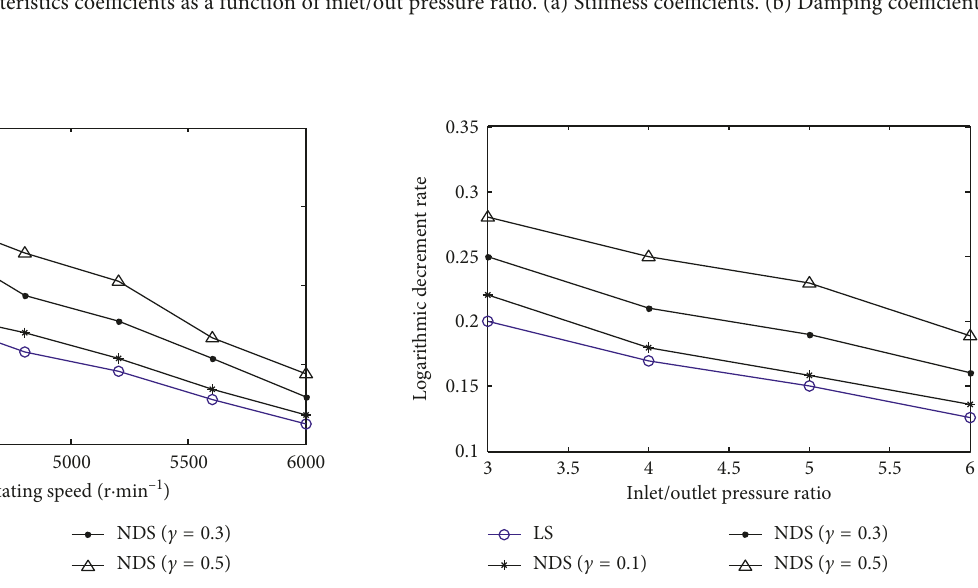
Figure 11: Dynamic characteristics coefficients as a function of inlet/out pressure ratio. (a) Stiffness coefficients. (b) Damping coefficients.